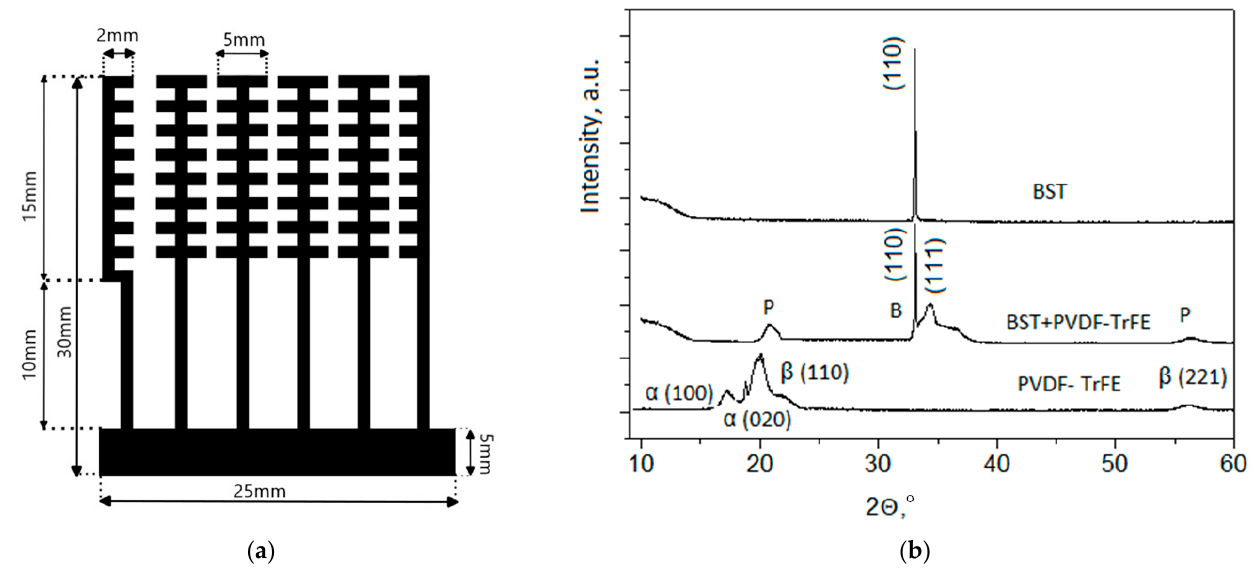
Figure 1. Design of the measured sample ( a ) and XRD patterns of BST, PVDF-TrFE, and BST+PVDF-TrFE composite ( b ).